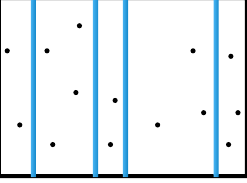
FIG. 10. A generalized Szilard box with multiple particles [20]. FIG. 11. The sawtooth potential of the flashing ratchet, from Ref.